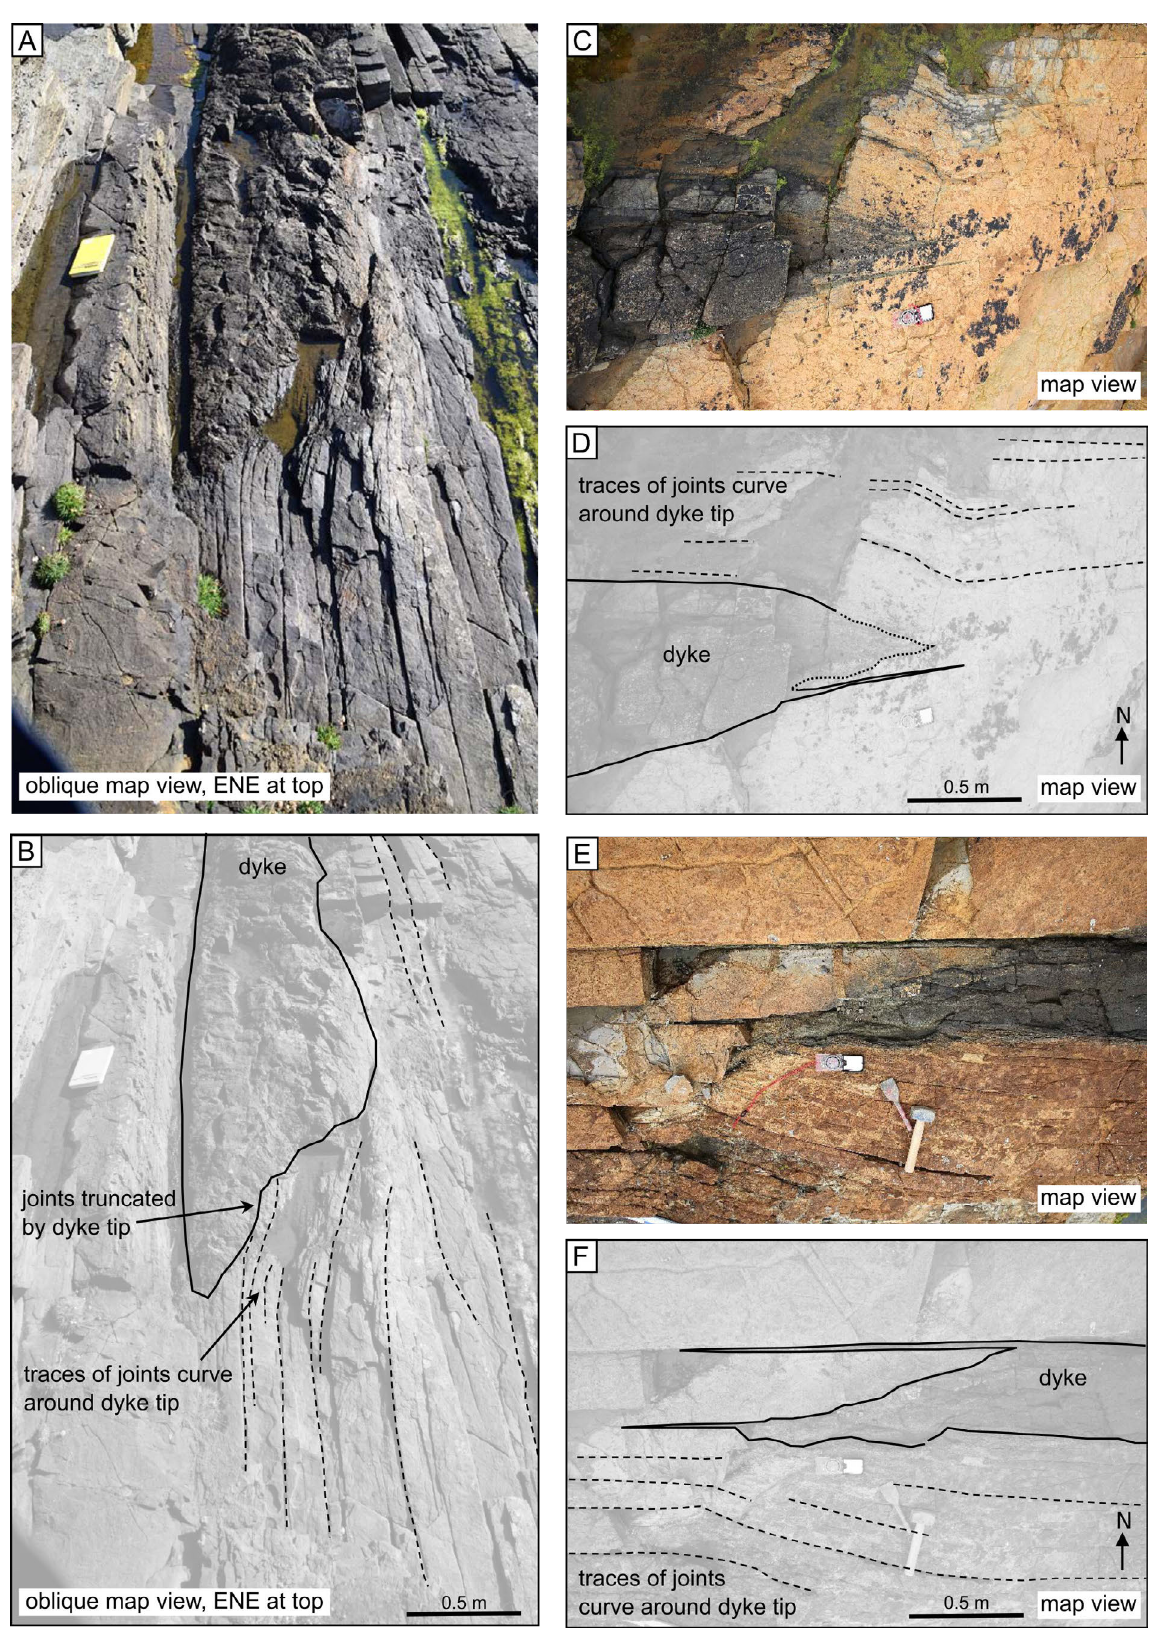
Figure 10: Caption on next